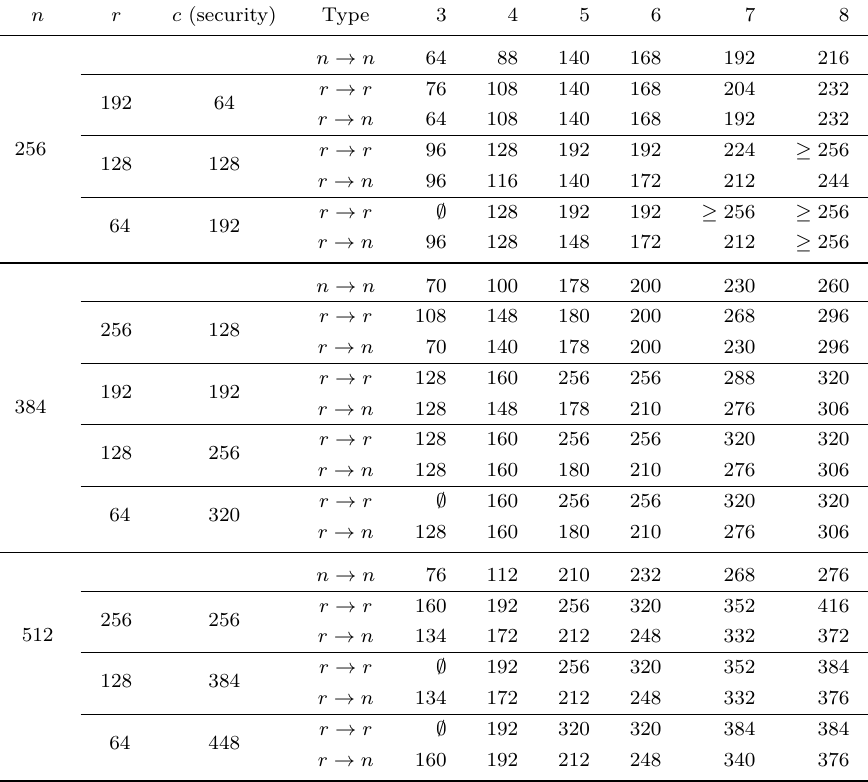
Table 8: The quantity − log ( 𝑝 ) where 𝑝 is an upper bound on the probability of a 2 differential trail over one call to Sparkle where both the input and the output differences are fully contained in the rate. The ∅ symbols means that such trails impossible. 𝑟 → 𝑟 denotes “rate to rate” trails and 𝑟 → 𝑛 denotes trails where the input is in the rate but the output is not